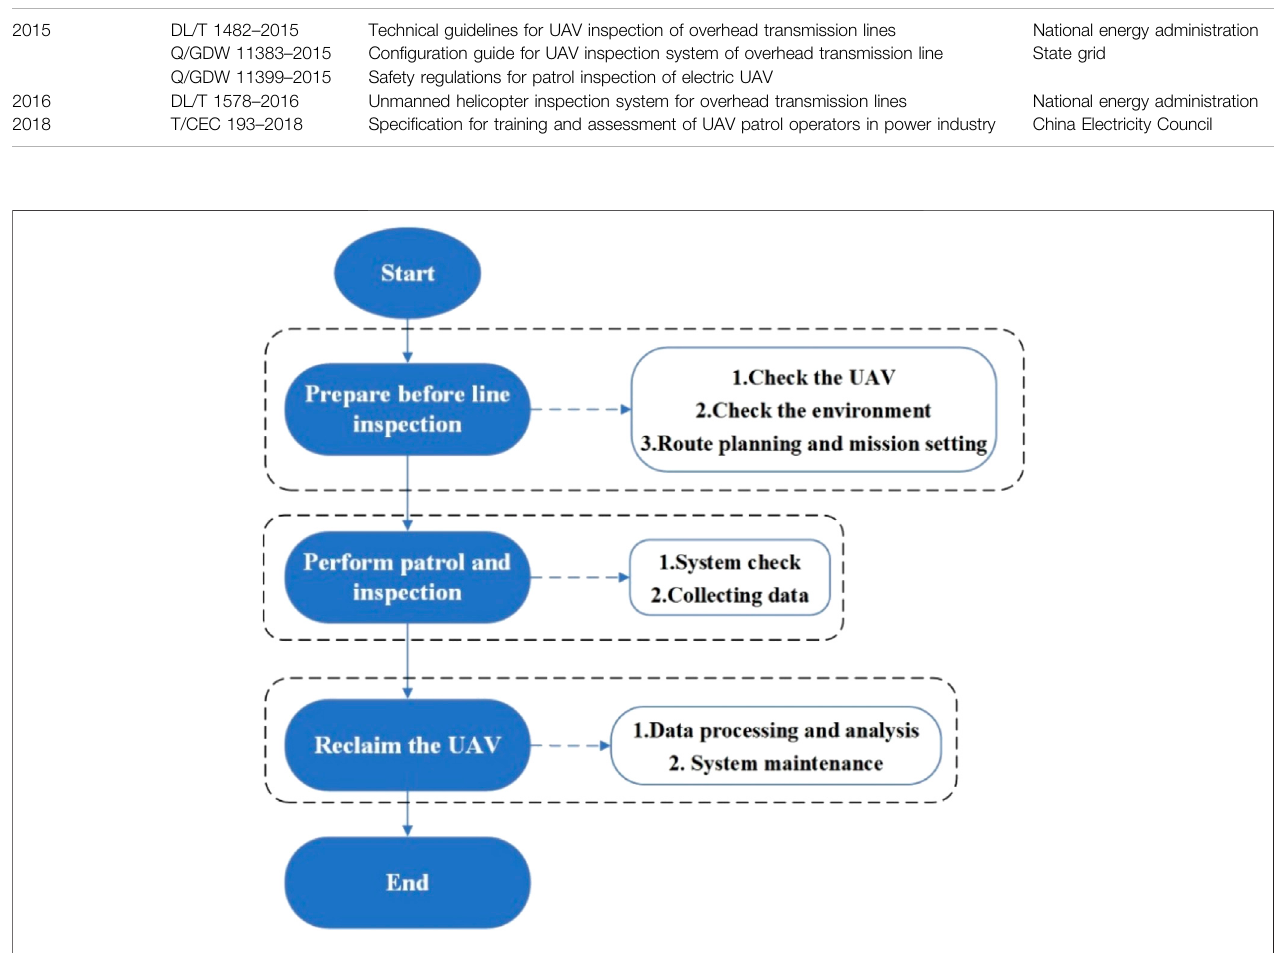
FIGURE 7 | UAV line inspection